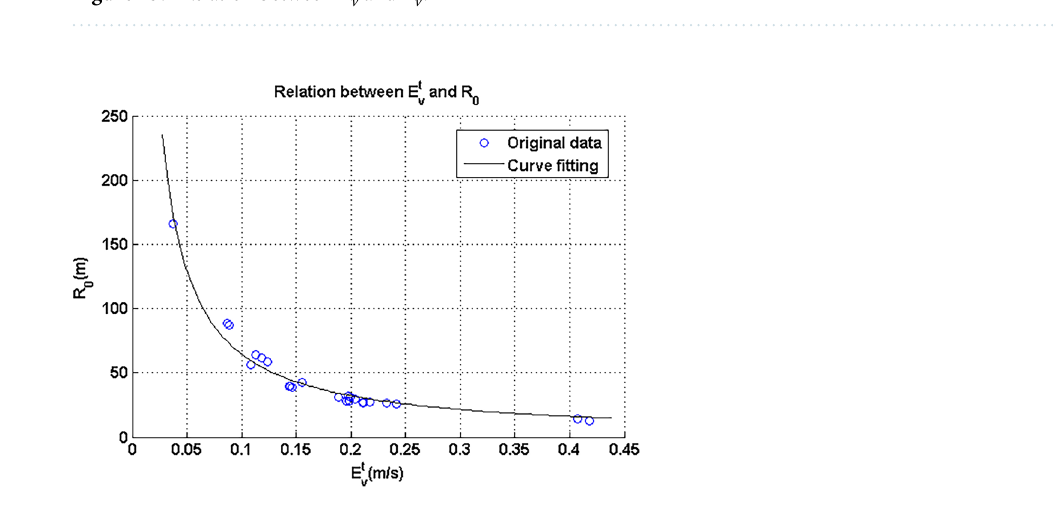
Figure 13. Relation between E t v and E a v .